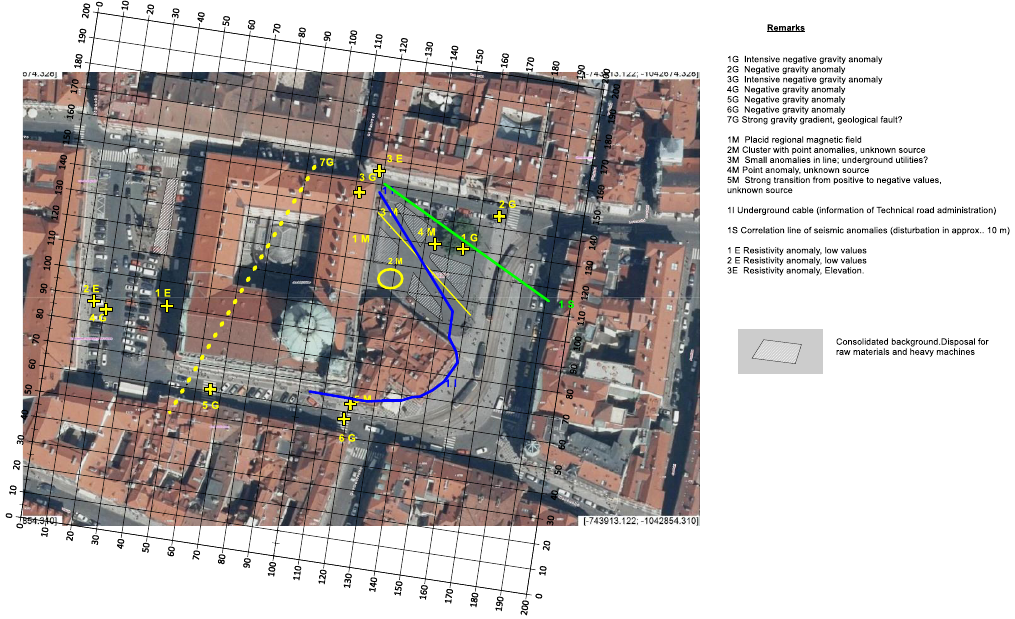
Figure 25. Lesser Town Square. Summary of geophysical results and anomalies. G—gravity, M—magnetometry, E—resistivity, I—underground utility.